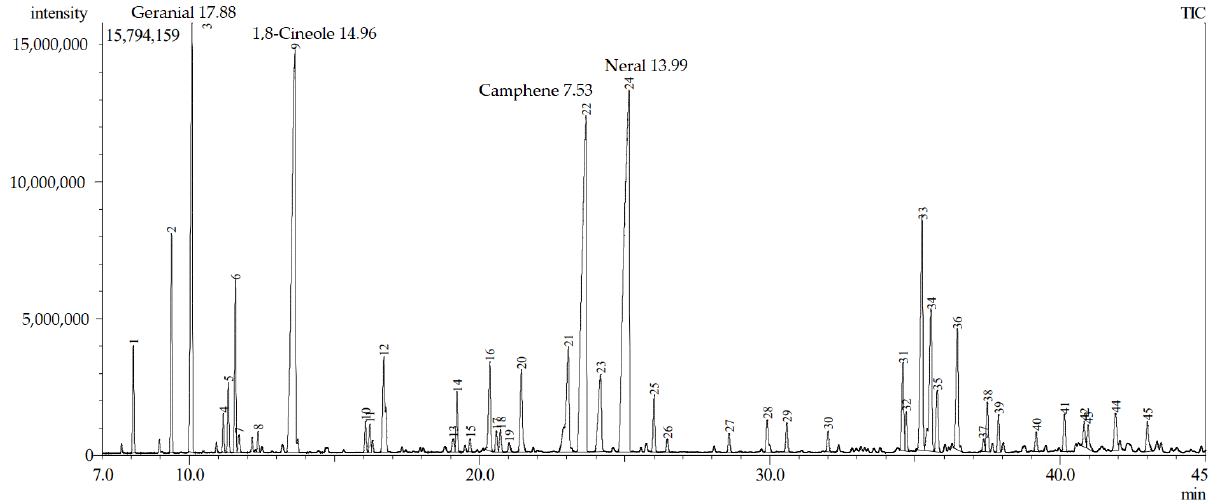
Figure 1. GC–MS chromatogram phytochemical analysis of ginger essential oil.